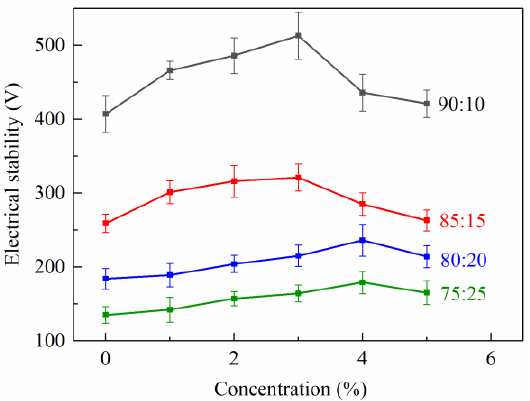
Figure 5. Effect of TQ-1 on the electrical stability of emulsions with different oil-to-water ratios (error bars represent standard deviation). The standard deviation values range from 9.5 to 32.0 V based on the oil-to-water ratio and TQ-1 concentration.